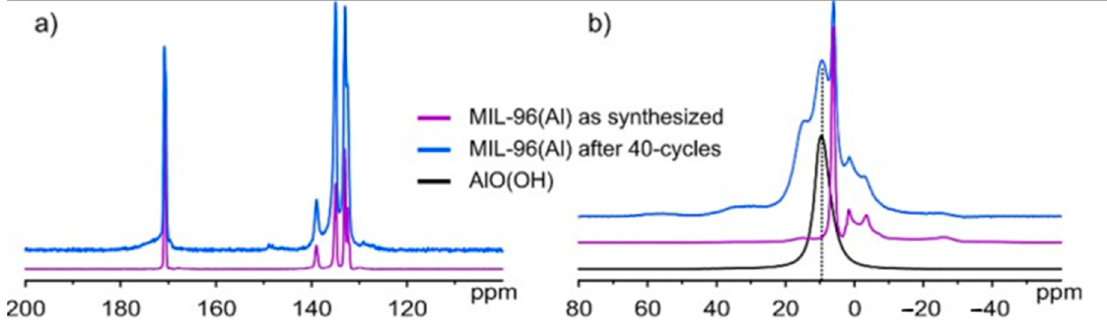
Figure 7. ( a ) 1 H- 13 C CPMAS NMR spectra of MIL-96(Al) before and after cycling test; ( b ) 27 Al single pulse NMR spectra of AlO(OH), as-synthesized MIL-96(Al) and MIL-96(Al) after